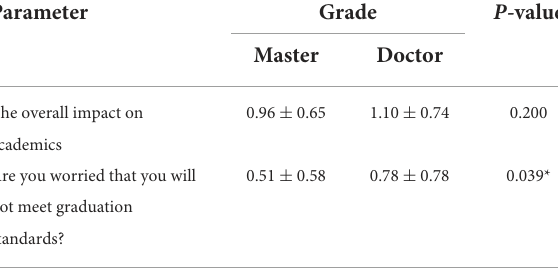
TABLE 8 Comparison of the academic studies taken by grade.